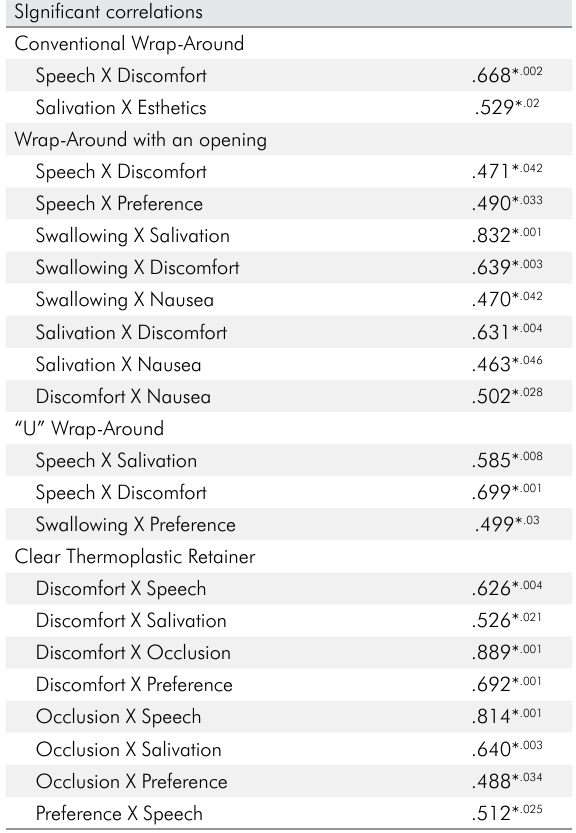
Table 3. Significant correlations between perceptions on different